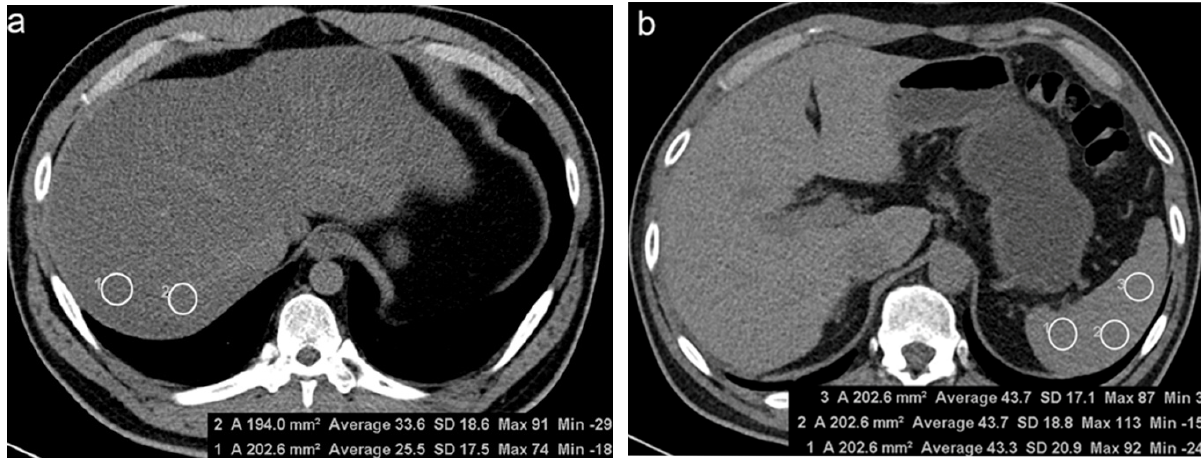
Figure 2. Measurement of hepatic ( a ) and splenic ( b ) attenuation on non-enhanced computed tomography. ( a ) Two 2 cm 2 circular regions of interest (ROIs) were manually drawn at segment VII. ( b ) Three 2 cm 2 ROIs were manually at three different sites in the middle third of the spleen.